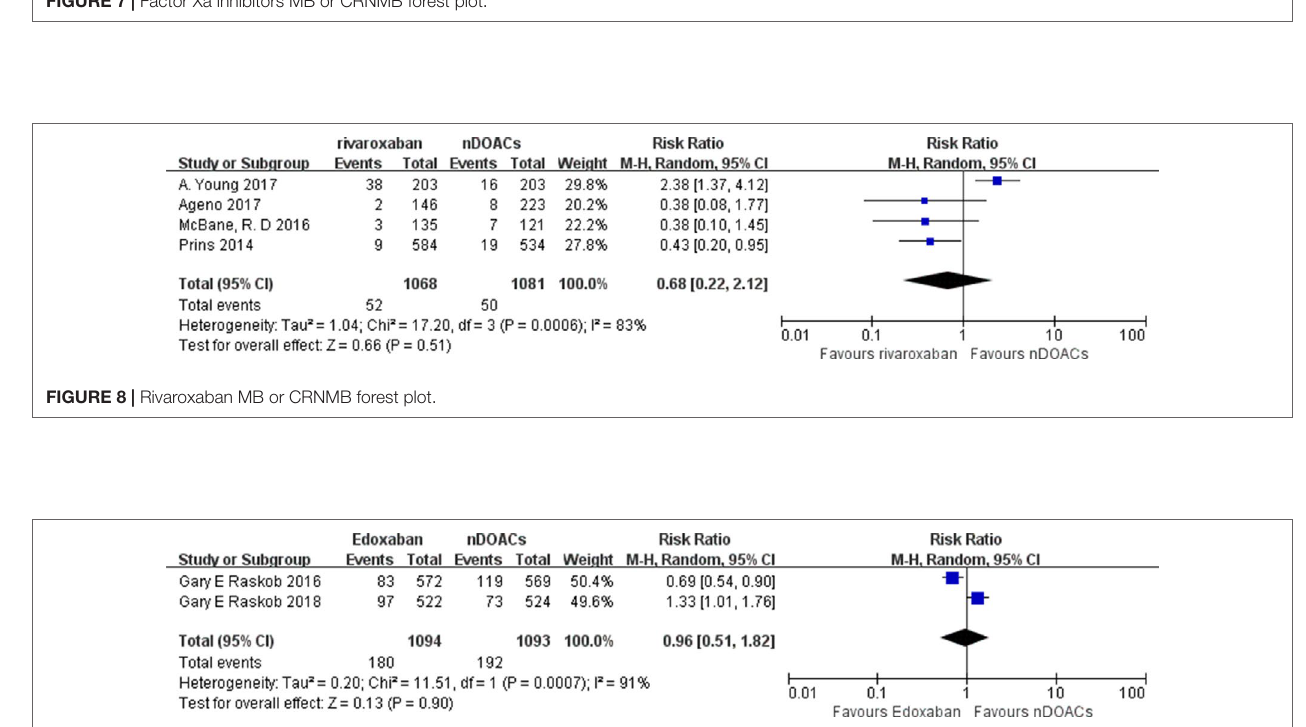
FIGURE 7 | Factor Xa inhibitors MB or CRNMB forest plot.